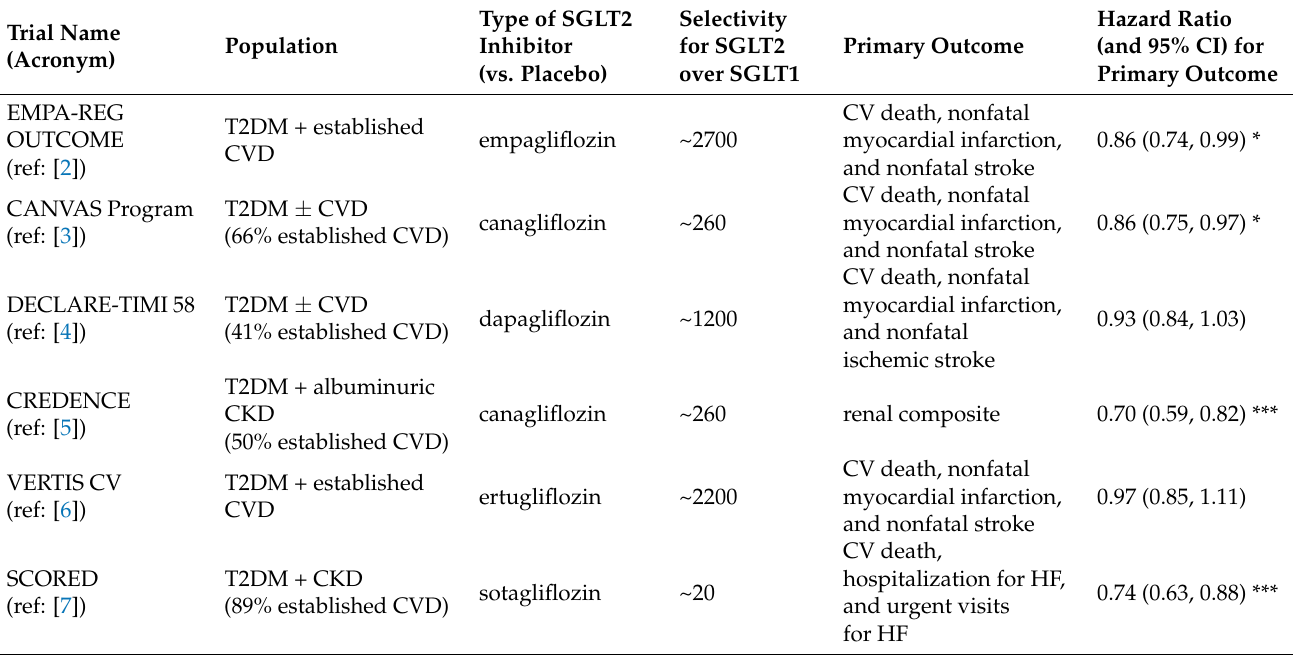
Table 1. Summary of cardiovascular outcome trials with sodium–glucose cotransporter 2 (SGLT2) inhibitors and the